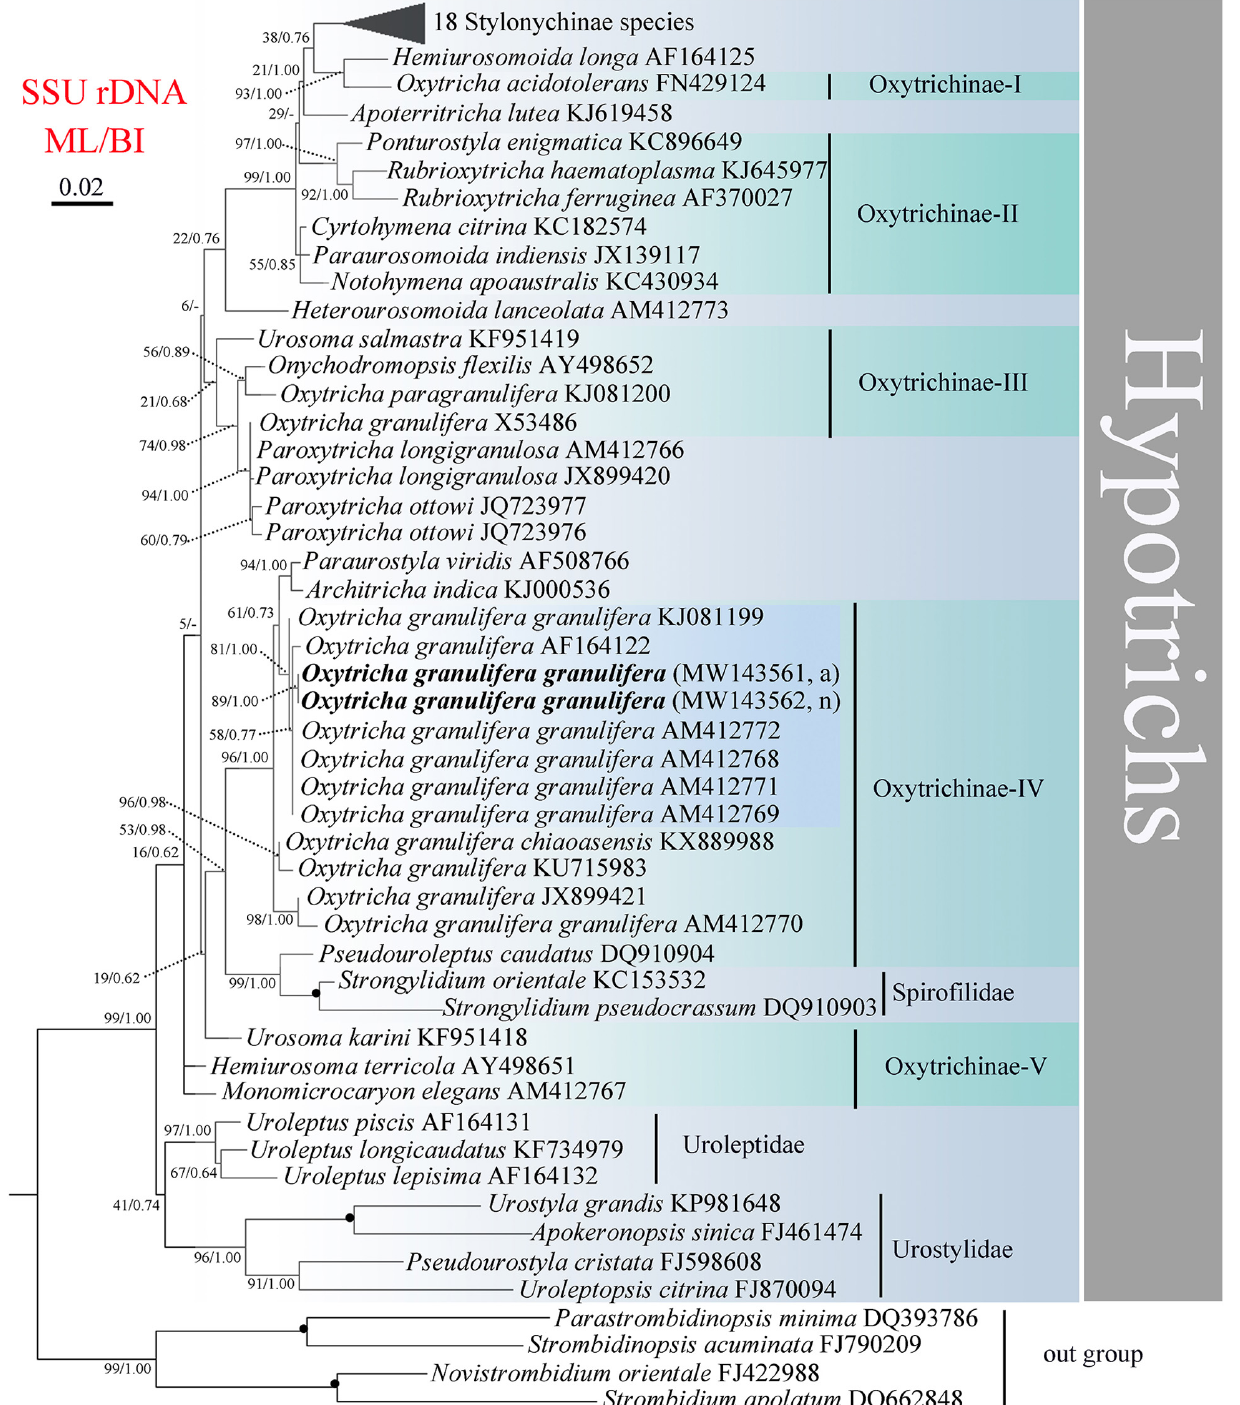
Frontiers in Marine Science |